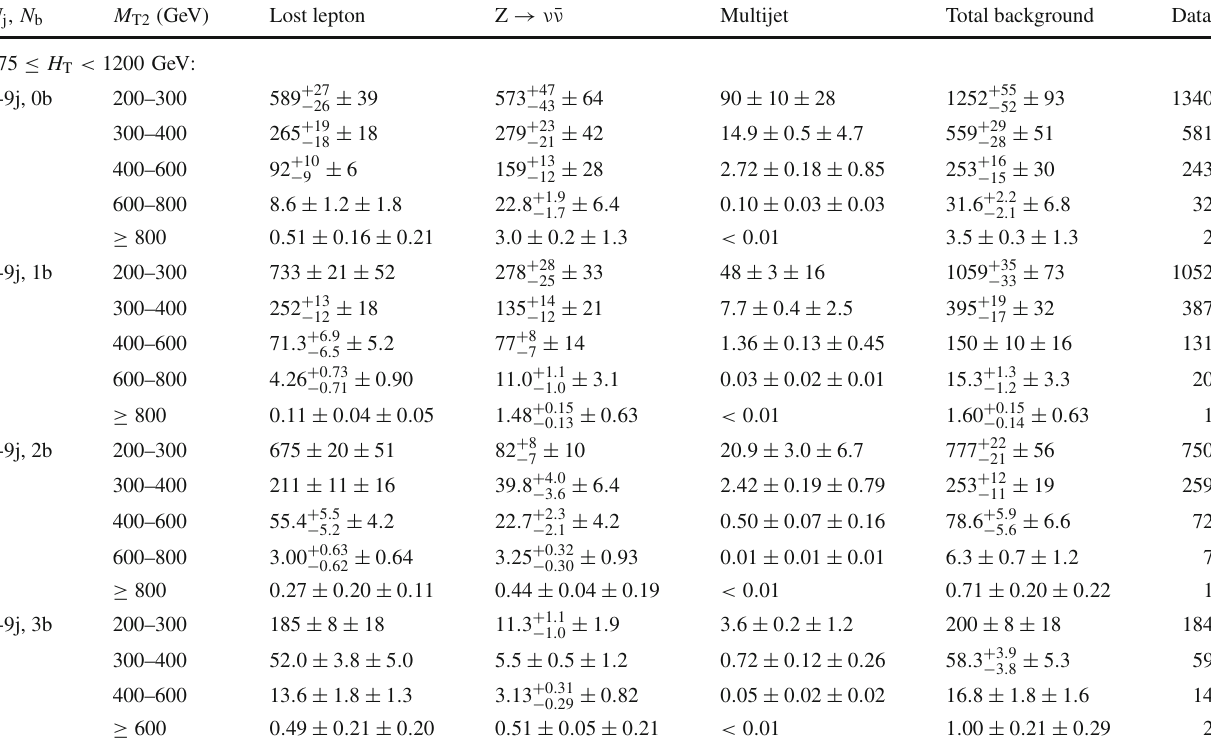
Table 18 Predictions and observations for the 34 search regions with 575 ≤ H T < 1200 GeV, and 7 ≤ N j ≤ 9, or N j ≥ 10. For each of the background predictions, the first uncertainty listed is statistical (from N j , N